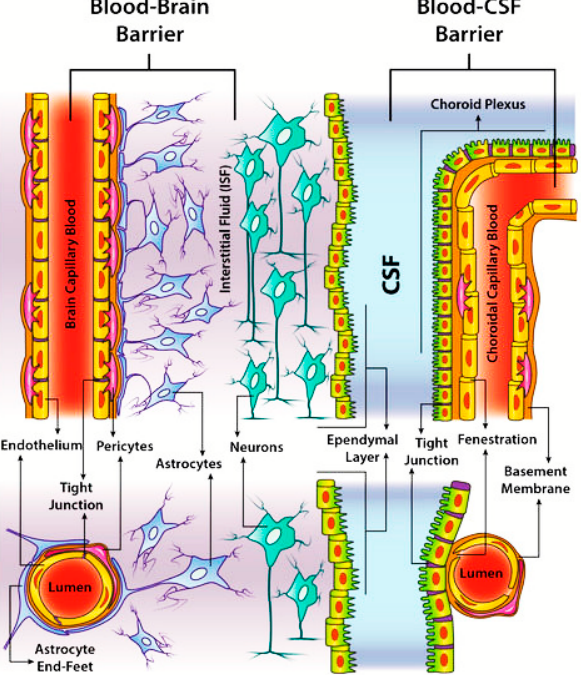
Figure 3. Representation of the main barriers for CNS drug delivery: blood–brain barrier (BBB) and blood–cerebrospinal fluid barrier (B-CSF). The cellular types are also shown. Reproduced from [29].